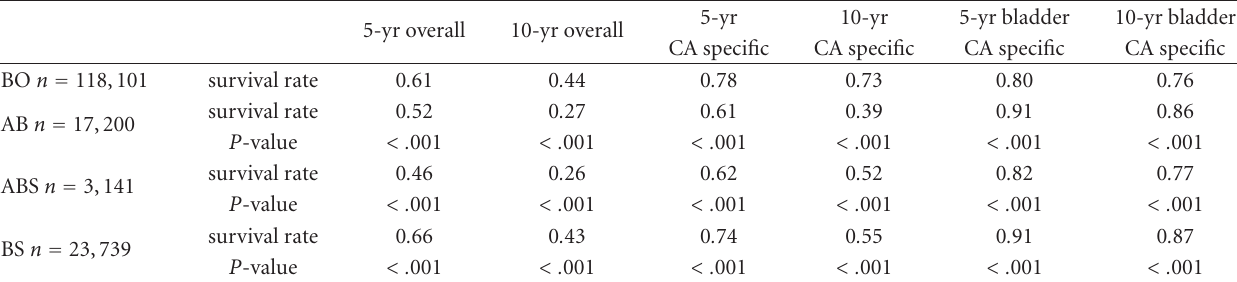
Table 2: Survival rates for single and multiple malignancy cohorts, univariate